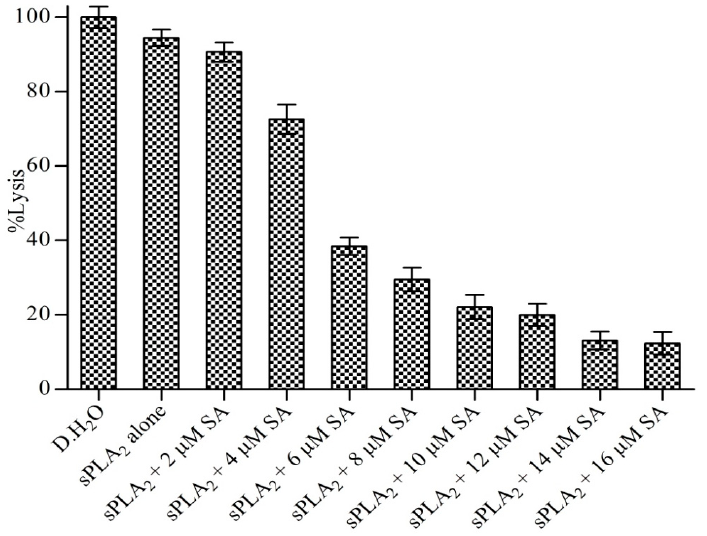
Figure 9. Neutralization of sPLA2-IIA induced indirect hemolytic activity: The reaction was initiated by adding 1 mL of substrate to preincubated sPLA 2 -IIA with indicated concentration sinapic acid and incubated at 37 °C for 30 min. The released hemoglobin was measured by reading the optical density at 540 nm. Data represent the mean standard deviation (n = 3).